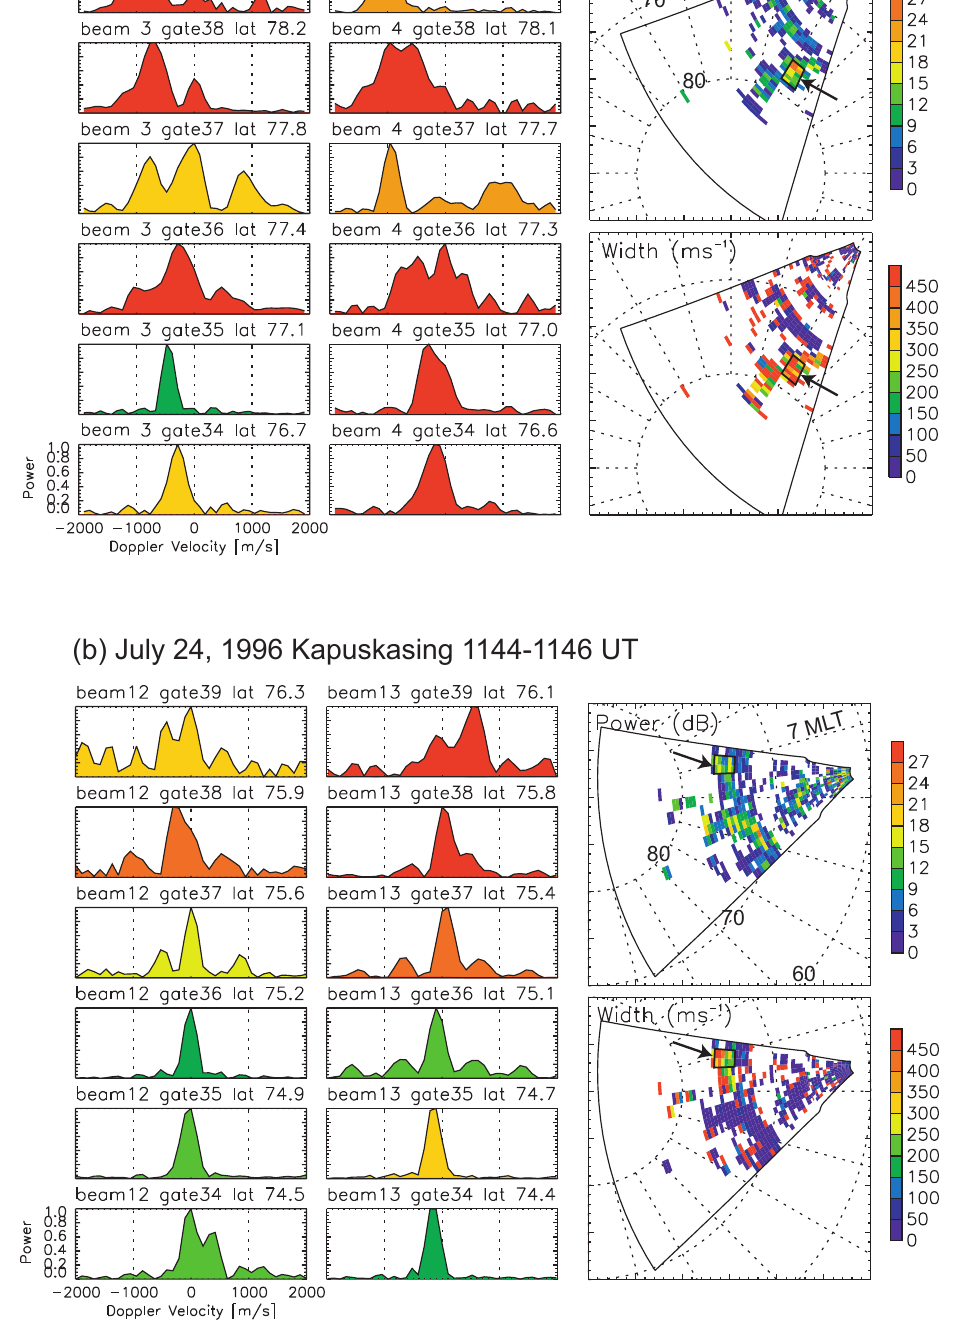
Fig. 4. Self-normalized Doppler spectra from the representative radar cells of extremely broad spectral widths during the periods of (a) 13:14–13:16UT in the 22 May event, and (b) 11:44–11:46UT in the 24 July event, respectively. Spectral widths derived by the FITACF analysis are also shown in individual Doppler spectra with a color scale displayed on the right. Right panels show the color-coded backscatter power and spectral width in the polar map for the same scan period. Selected cells are arrowed and enclosed by solid